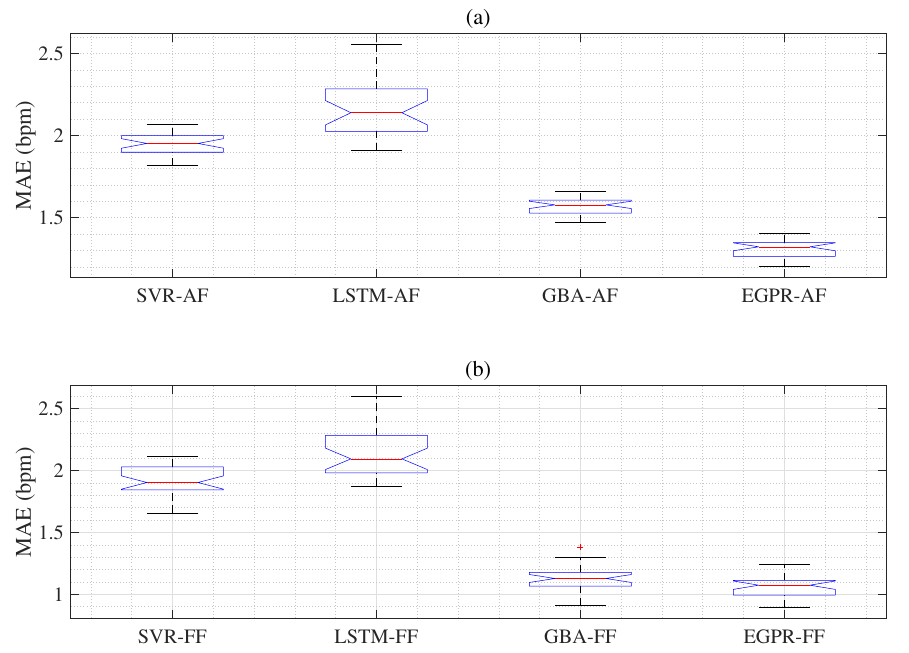
Figure 7. Top panel ( a ) denotes the MAE and SD compared to the reference RR method obtained using the dual signals based hybrid feature extraction and arithmetic fusion (AF) models., and Bottom panel ( b ) shows the MAE and SD compared to the reference RR method obtained using the dual signals based hybrid feature extraction and feature fusion (FF) models.